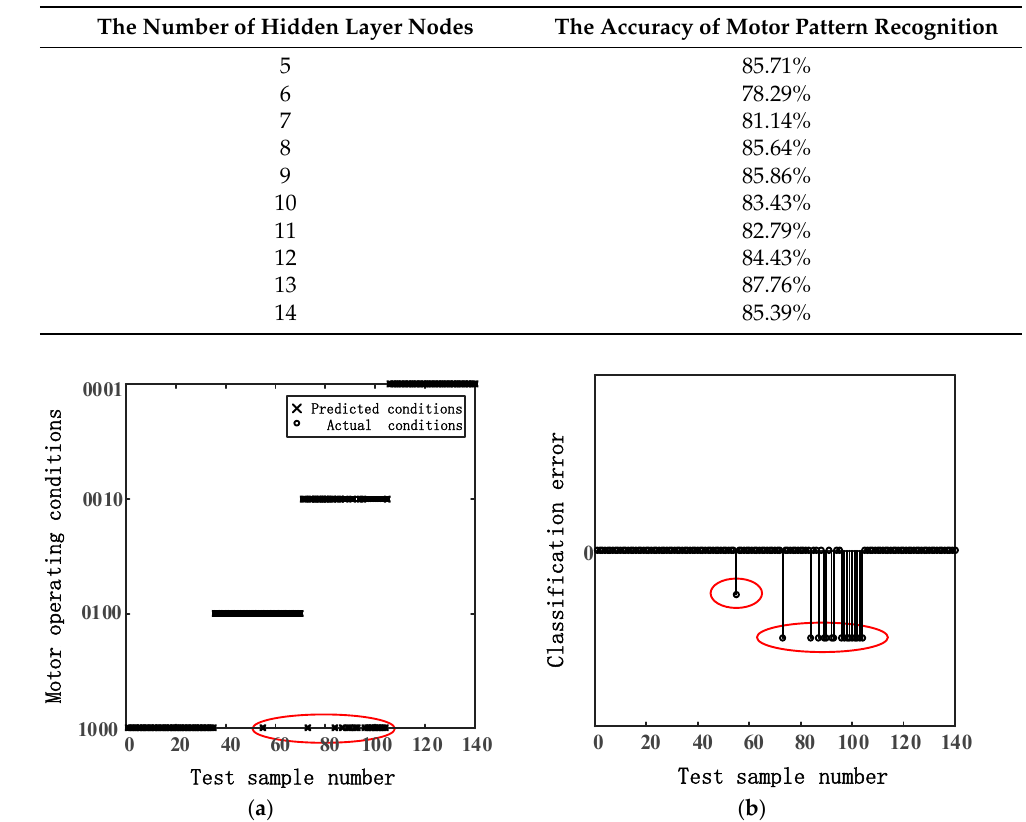
Figure 8. The results of motor fault pattern recognition. ( a ) Classification results; ( b ) classification